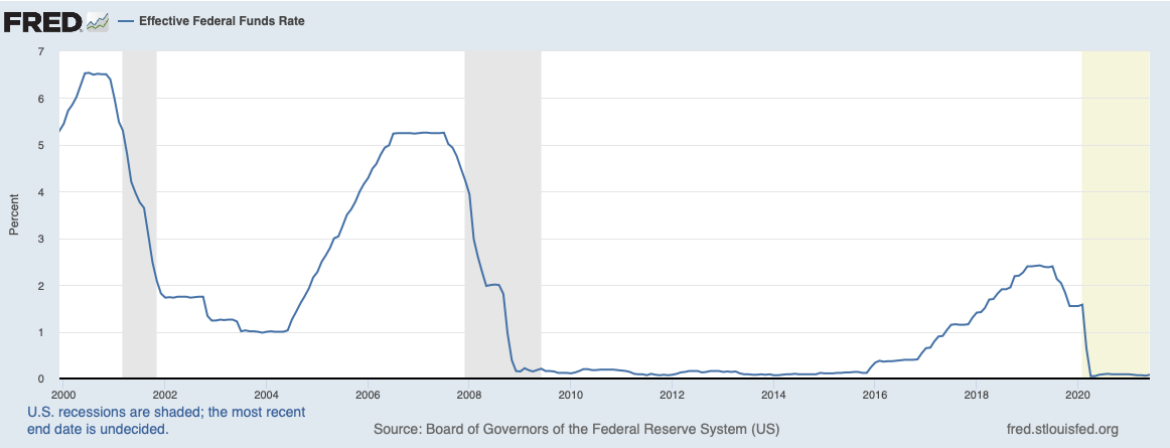
Figure 1. Federal Fund Rate time series. 1 January 2000–1 June